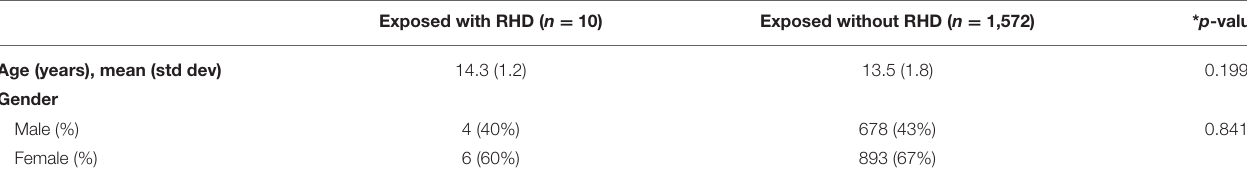
TABLE 1 | Demographic data of children with a prior negative screening echo (exposed cohort) with and without